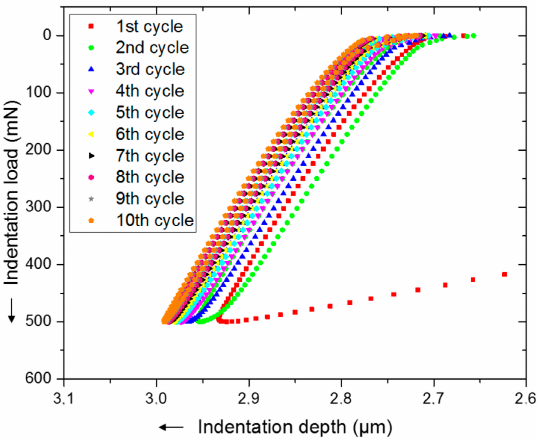
Figure 3. Experimental load-depth curves of cyclic indentation (10 loading–unloading cycles).